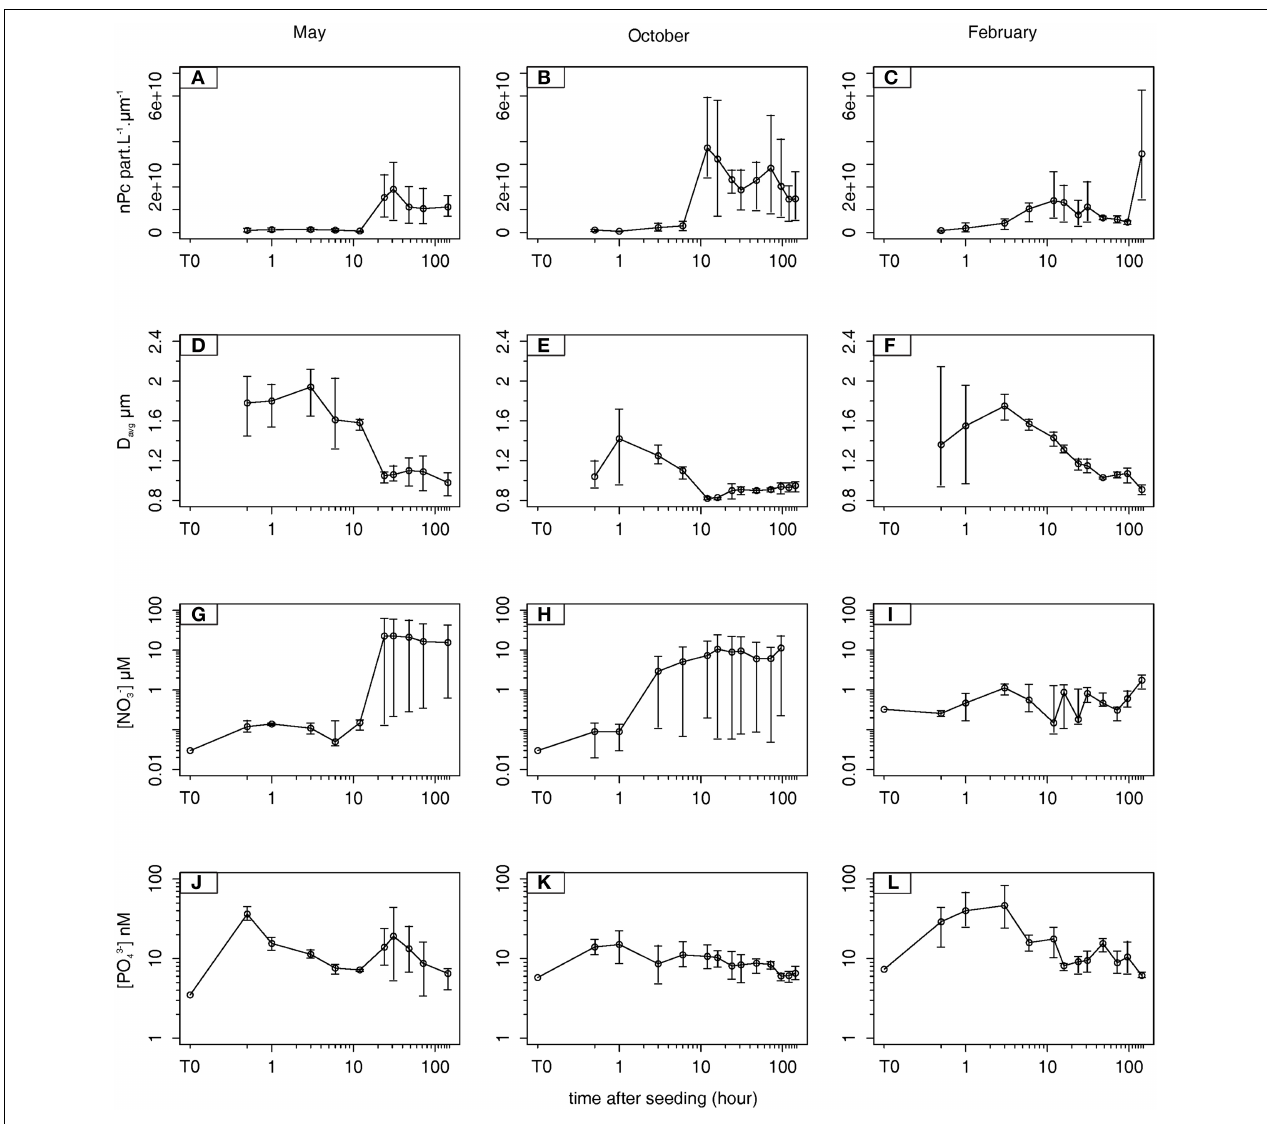
FIGURE 2 | Temporal evolution of the 3-depths averaged number of particles (nPc, part L − 1 μ m − 1 ) (A, B, C), the 3-depths averaged diameter of particles (D avg , μ m) (D, E, F), the 3-depths averaged nitrate concentrations ([NO − 3 ] avg , μ mol L − 1 ) (G, H, I), and the